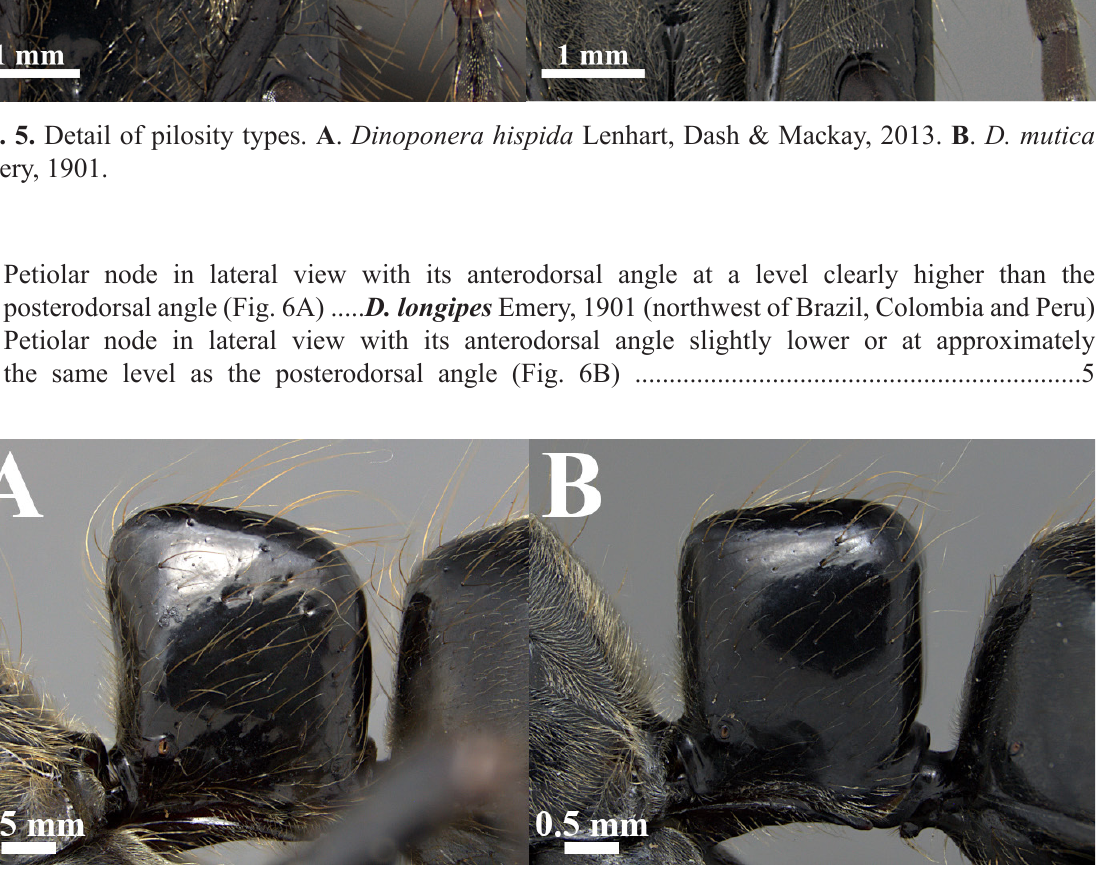
Fig. 6. Petiolar node in lateral view. A . Dinoponera longipes Emery, 1901. B . D . mutica